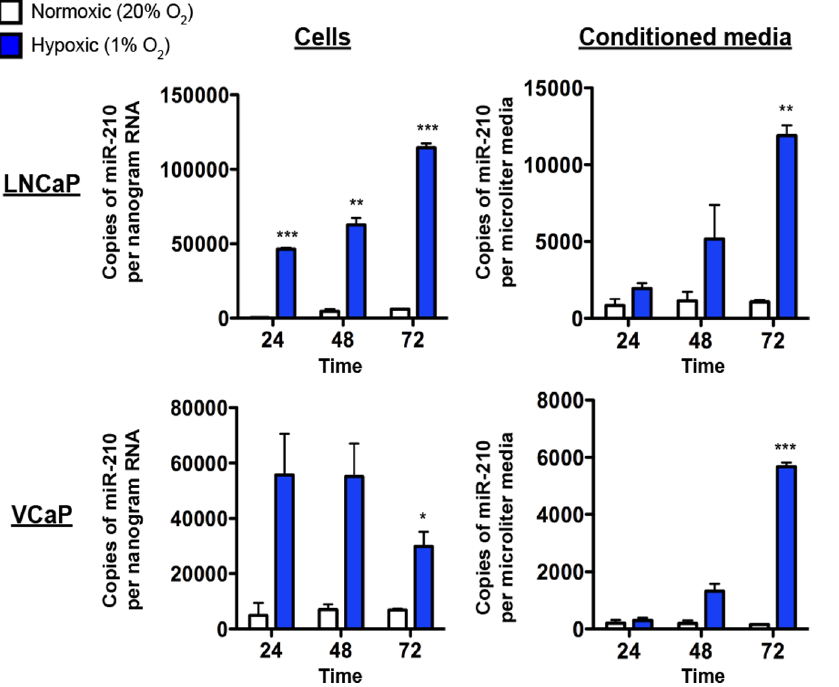
Figure 2. Exposure of prostate cancer cell lines to hypoxia induces production and release of miR-210 into the extracellular environment. Left column, miR-210 copies/ng RNA in LNCaP and VCaP human prostate cancer cell lines cultured in normoxic (20% O 2 ) (white bars) or hypoxic (1% O 2 ) (blue bars) conditions for 24, 48 or 72 hours. Right column, miR-210 copies/ m l in filtered conditioned media corresponding to cellular samples. *, P value , 0.05; **, P value , 0.01; ***, P value , 0.001 (Student’s